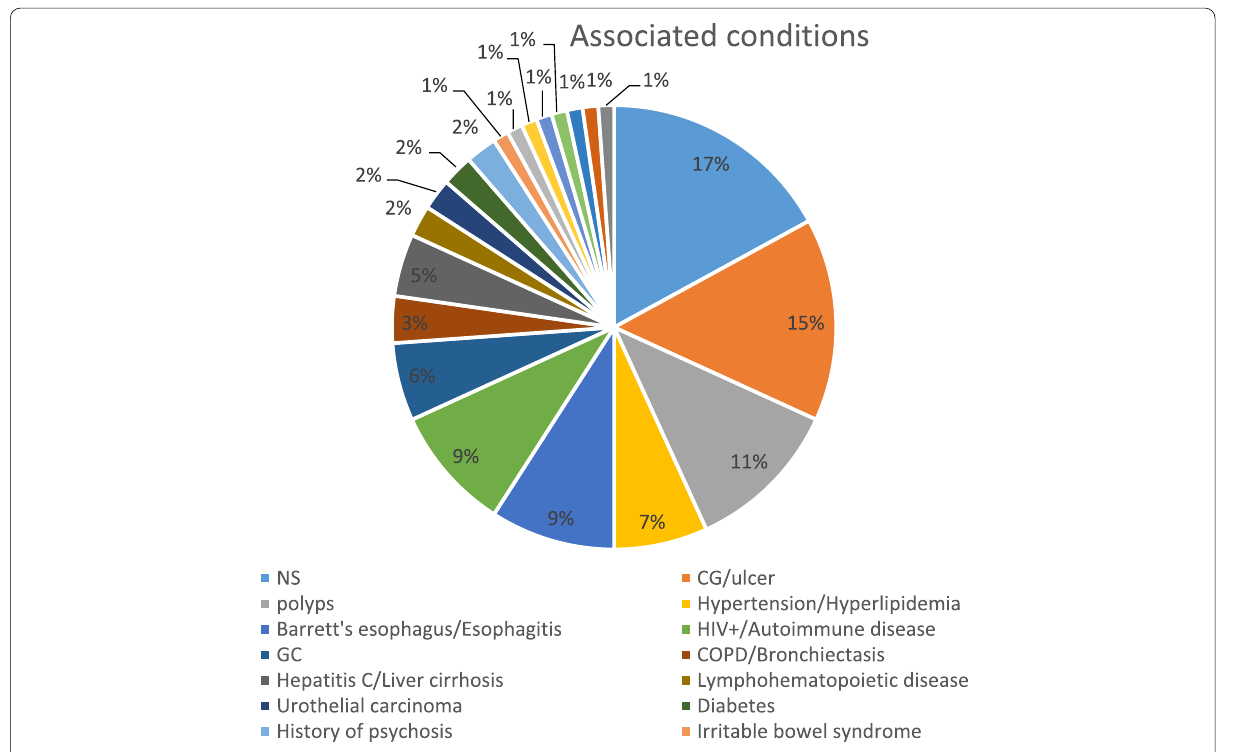
Fig. 8 Associated conditions in patients with Russell body inflammation in the digestive tract according to the available